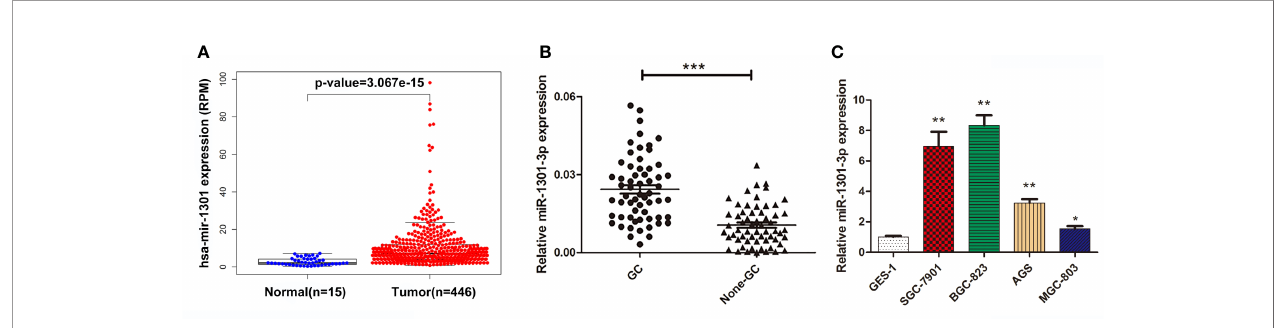
FIGURE 1 | Expression of miR-1301 in human gastric tissues and cells. (A) The expression levels of miR-1301 in TCGA database. (B) The expression levels of miR- 1301-3p in 60 pairs of GC and adjacent normal tissues. (C) The expression levels of miR-1301-3p in GES-1 and GC cells. *p < 0.05, **p < 0.01, ***p <